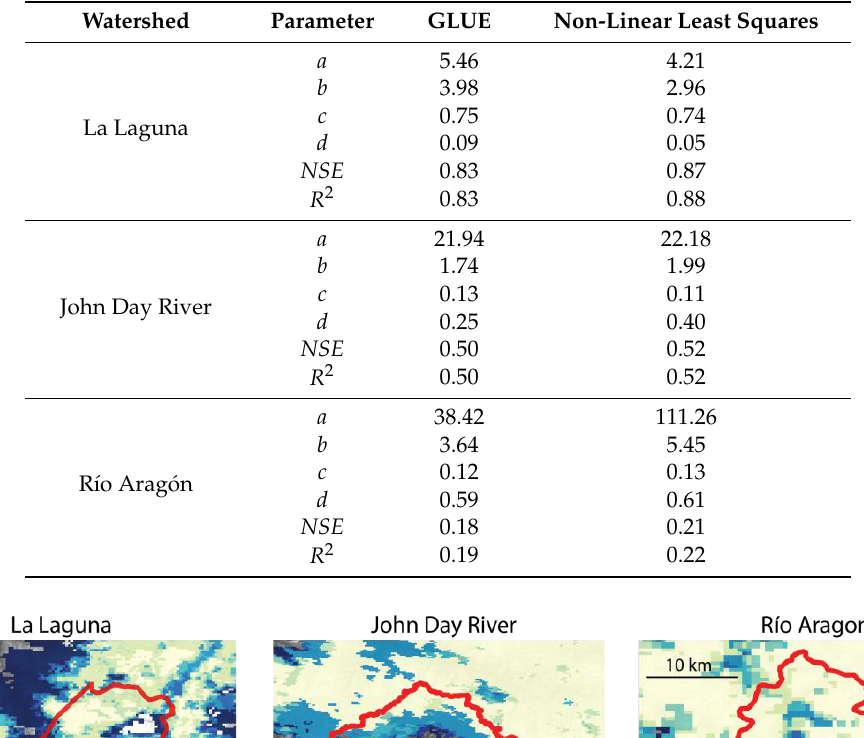
Table 2. Values for the different model parameters ( a – d ) from the GLUE and non-linear least squares methods from the three study watersheds. The R 2 values associated with method are also provided.